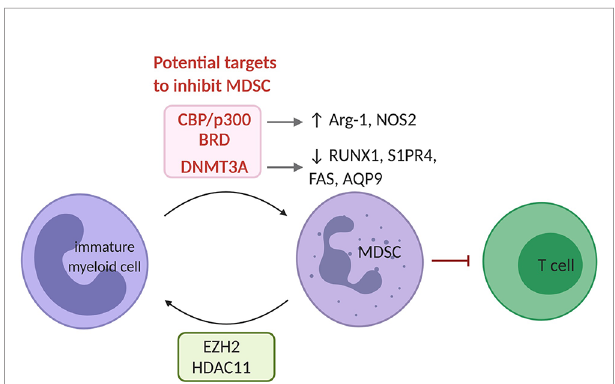
FIGURE 3 | The epigenetic landscape of MDSC. EZH2 and HDAC11 serve as negative regulators of MDSC differentiation from immature myeloid. In MDSC, the bromodomain (BRD) of CBP/p300 acts as a critical regulator of H3K27Ac across promoters and enhancers of pro-tumorigenic target genes such as Arg-1 and NOS2. Also, increased DNMT3A levels have been shown in MDSC and have been linked to repression of immunity-related genes such RUNX1, S1PR4, FAS and AQP9 . CBP/p300 and its bromodomain or DNMT3A represent potential targets to inhibit MDSC. MDSC, myeloid derived suppressor cell; HDAC, histone